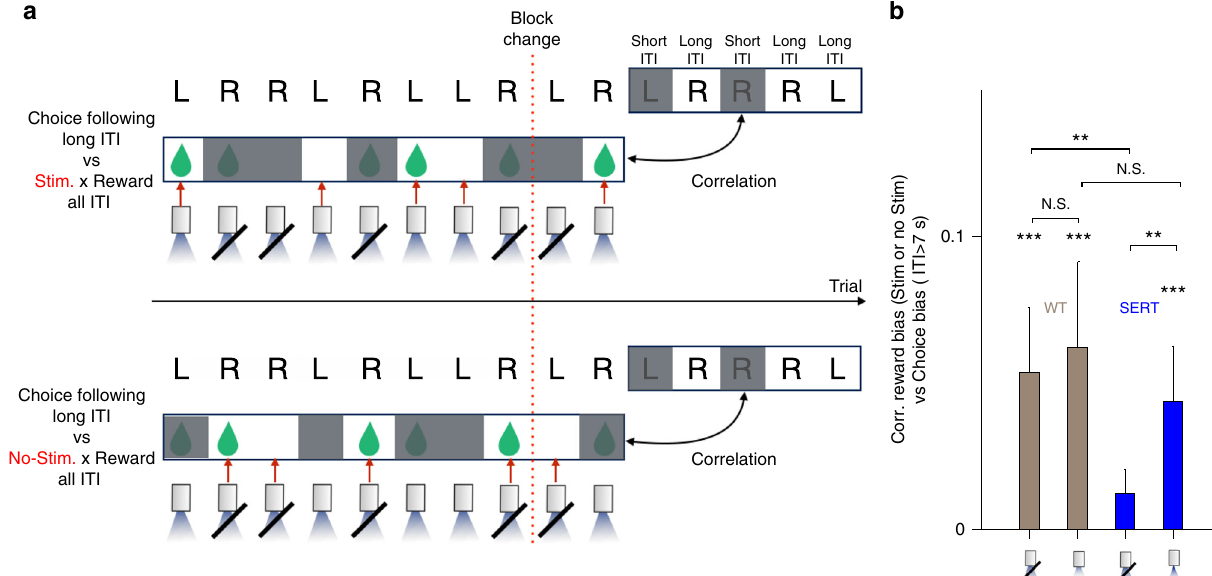
Fig. 2 Enhanced learning from DRN stimulation. a Schematic diagram of the model-agnostic analysis. The correlation between the recent reward bias (window = 10 trials) and choices following long ITIs (window = 5 trials) was estimated using adjacent sliding windows. The reward bias was estimated on trials only with (top) or without (bottom) photo-stimulation, but regardless of the duration of ITIs. The choice bias was estimated only for choices following long ITIs, regardless of the presence of stimulation or reward. The grayed out trials in this example were ignored for the assessments. The windows were shifted together one trial at a time. For each realization of the sliding windows, the reward and adjacent choice biases were estimated. However, we excluded cases in which the choice window contained no long ITI trials. By sliding these windows, we obtained many pairs of reward bias and choice bias. We then estimated Pearson ’ s correlation from these points, separately for each mouse. Note that, due to the task design in which photo-stimulation is associated with only one side (left or right) in a given block, in some moving windows reward bias had to be computed from one side only. Thus, we assigned + 1 (respectively − 1) to a reward from left (right) and no-reward from right (left) when we computed reward bias. We are aware that this is not a perfect measure for reward bias; but we still expect fi nite correlations since reward rates from the left choice and the right choice are on average negatively correlated by the task design in a given block (reward probability: 0.1 vs 0.4). b Model-agnostic analysis suggests that the impact of reward history on choices following long ITIs was modulated by optogenetic stimulation. The x -axis indicates if the reward bias was computed over trials with or without photo-stimulations. The stars indicate how signi fi cantly the correlation is different from zero, or the correlations are different from each other, tested by a permutation test, where estimated reward bias was permuted within or between conditions. Three stars indicates p < 0.001. The error bars indicate the mean ± SEM of subjects ( n =